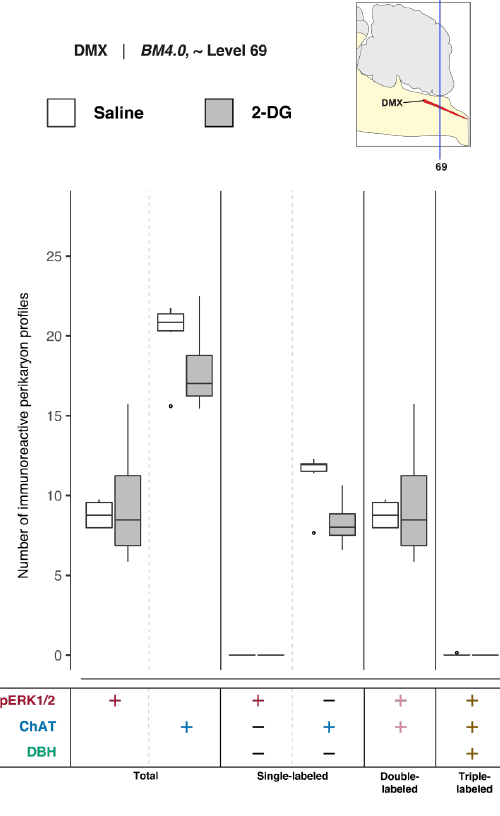
Figure 11. 2-DG administration does not alter activation patterns in dorsal motor nucleus of vagus nerve (>1840) (DMX) cells registered to BM4.0 atlas level 69. Abercrombie-corrected [106] perikaryon profile counts from both saline- and 2-DG-treated subjects are represented as box plots displaying the total numbers of phospho-ERK1/2-, ChAT-, or DBH-immunoreactive profiles, or only the single- , double-, and triple-labeled profiles, from tissue sections identified to be in register with BM4.0 atlas level 69 (map, upper right ). Perikaryon profile count differences were not significant; see Tables S5 and S6 for a statistical summary. On the box plots, potential outliers are presented as open circles.